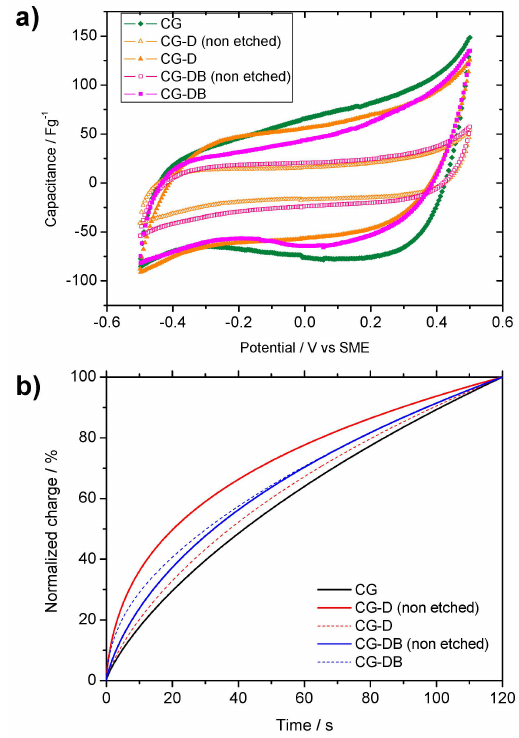
Figure 8. ( a ) Cyclic voltammograms of the studied aerogels recorded at 0.5 mV/s in 0.1 M NaCl; ( b ) Normalized relaxation chronocoulometric curves recorded for the studied samples after a potentiostatic pulse of 300 mV for 120